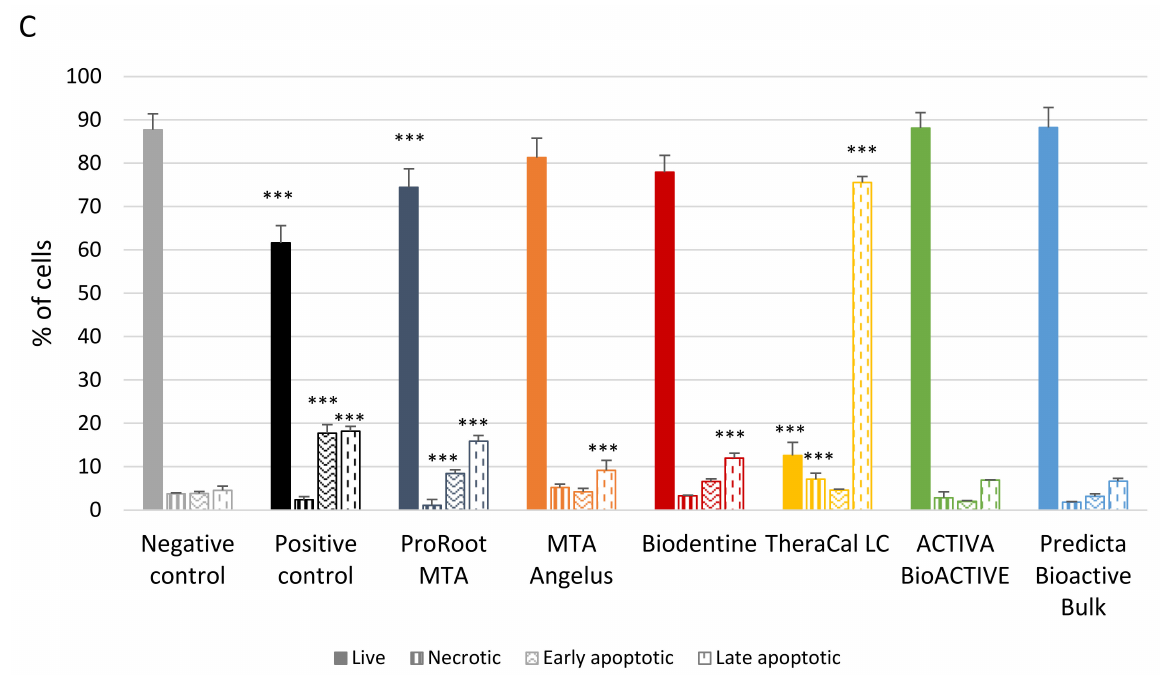
Figure 3. Flow cytometric FITC annexin V/propidium iodide (PI) double staining analysis of apoptosis after 24 h and 48 h incubation of cells with the tested compounds. Dot plot graphs indicate share of viable (FITC annexin V negative, PI negative), early apoptotic (FITC annexin V positive, PI negative) late apoptotic (FITC annexin V positive, PI positive) and necrotic (FITC annexin V negative, PI positive) cells ( A ). Percentage of cells in each group after 24 h are presented below ( B ) and 48 h incubation ( C ). ***—statistically significant difference ( p < 0.001).